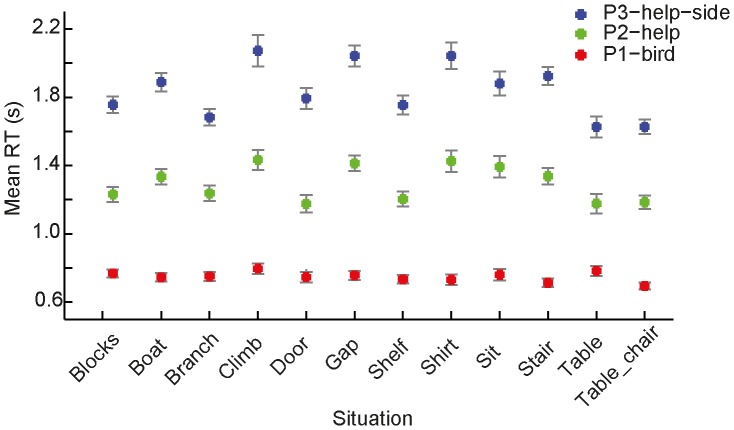
Interaction effect of scenario and situation on response times (RTs).Red symbols represent means for S1-bird, green symbols represent means for S2-help and blue ones represent means for P3-help-side. Note that differences between scenarios were not significant for all situations but that post-hoc tests confirmed that RTs were significantly different in all scenarios across situations (see Figure 5 for an illustration of the main effect). Error bars represent SEM.